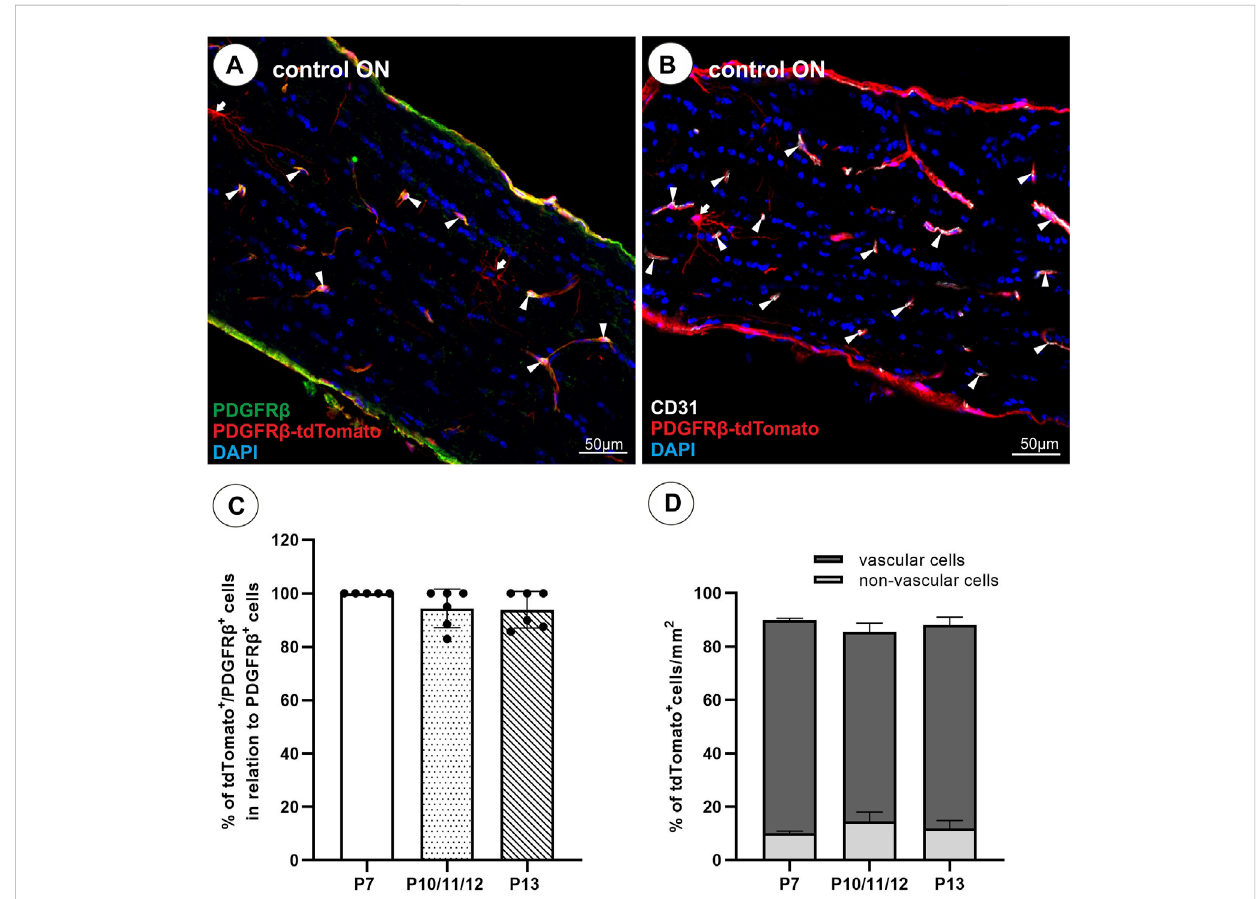
FIGURE 1 TdTomato reporter expression in the unlesioned ON. (A) Almost all PDGFR β + (green) cells revealed tdTomato + expression (red). (B) The majority of tdTomato + cellsareassociatedwithCD31 + vascularstructures(white),andaminorityoftdTomato + cellsrevealedabranched,non-vascularmorphology. (C) The amount of tdTomato + /PDGFR β + cells in the healthy ON calculated in relation to all PDGFR β + cells (%) following a TAM induction at P7, P10/11/12, or P13 (n = 5 – 6 per induction procedure). (D) Comparison of the percentage of tdTomato + cells associated with vascular structures versus non- vascular structures following a TAM induction at P7 ( n = 2), P10/11/12 ( n = 2), and P13 ( n = 3). Filled arrowheads show vascular tdTomato + cells, fi lled arrows show non-vascular tdTomato +